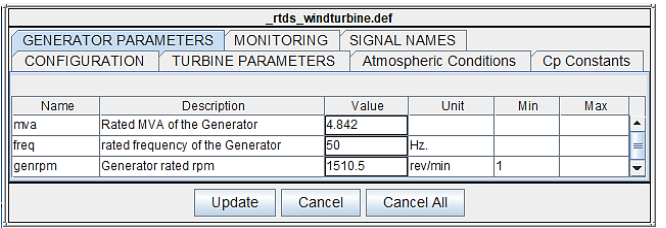
Figure 8. Wind turbine generator - rated apparent power (MVA), frequency, and rotor speed (rpm).